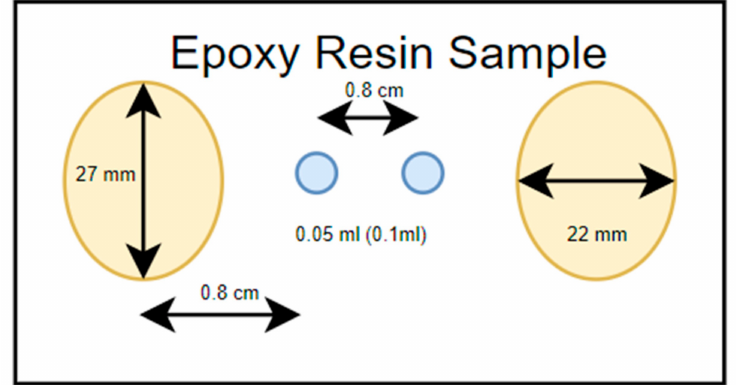
Figure 19. Two-Droplets Arrangement with one next to the other (2.1D).